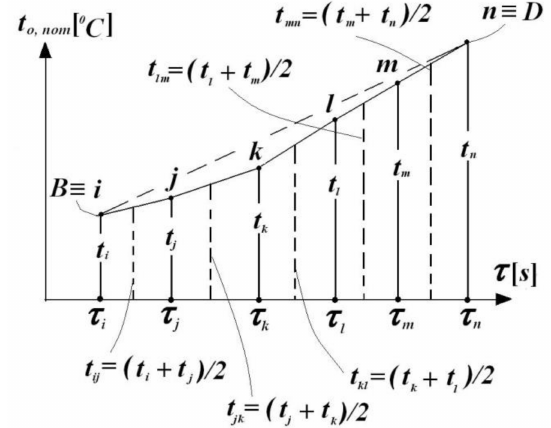
Figure 6. Temperatures of the heating stand.